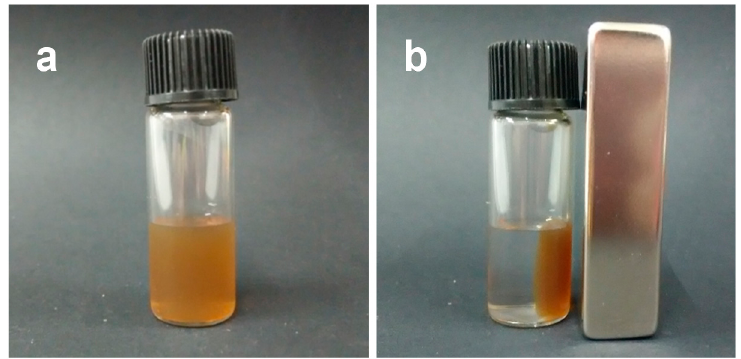
Figure 1. The magnetic separation behavior of CA-Fe 3 O 4 @Zn/AMP CPs. ( a ) Before; ( b ) After.